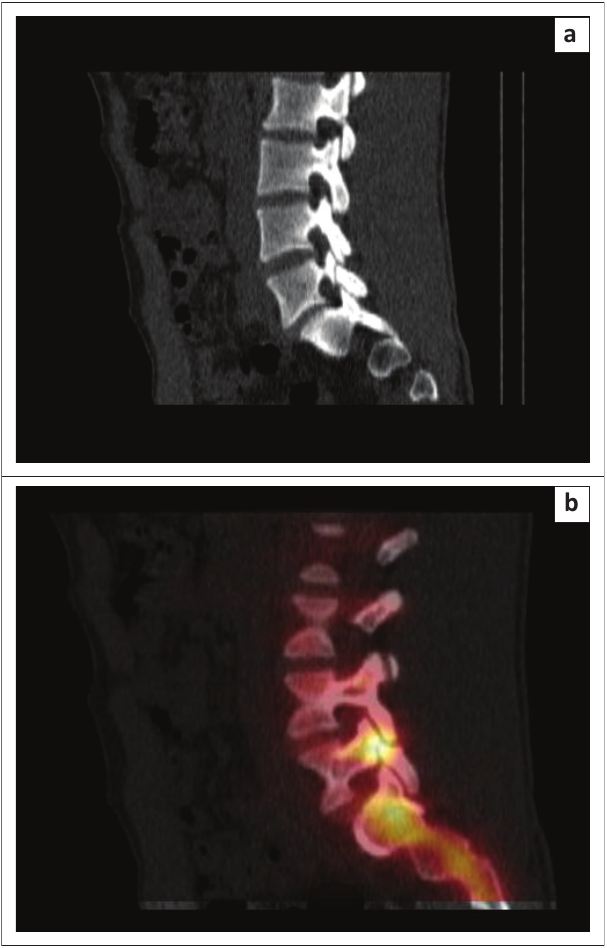
FIGURE 1: Sagittal low-dose CT (a) and fused sagittal SPECT-CT (b) images showing moderate to intense 99m Tc-MDP uptake localised to an oblique lucency traversing the right pars interarticularis of L5, in keeping with a fracture in a young athlete.